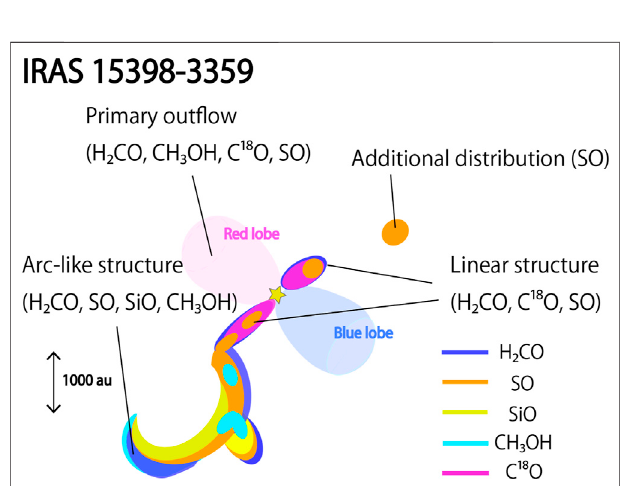
FIGURE4 | Adapted from (Okoda et al., 2021):Schematic picture ofthe moleculardistributions around the IRAS 15398 – 3359protostar located in the Lupus star-forming region. FAUST observations of emission lines due to different molecular species disentangle different components on large- scale associated with multiple out fl